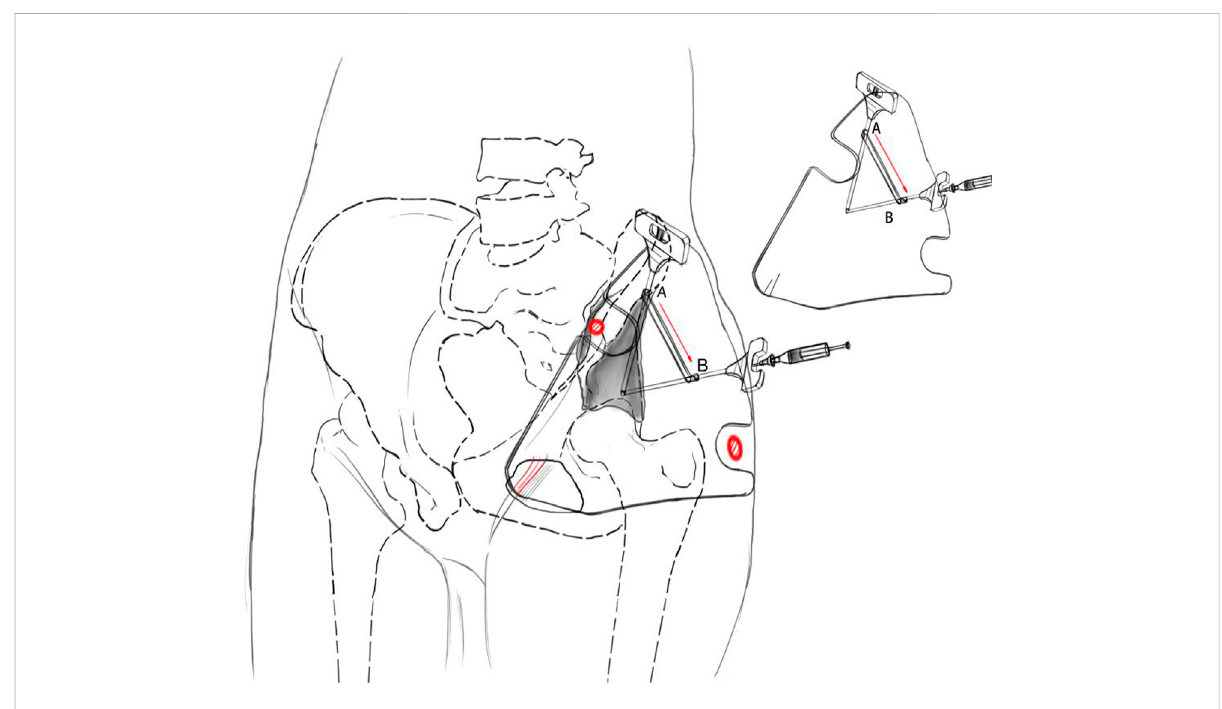
FIGURE 1 Design concept of the individualized guide plate for 3D